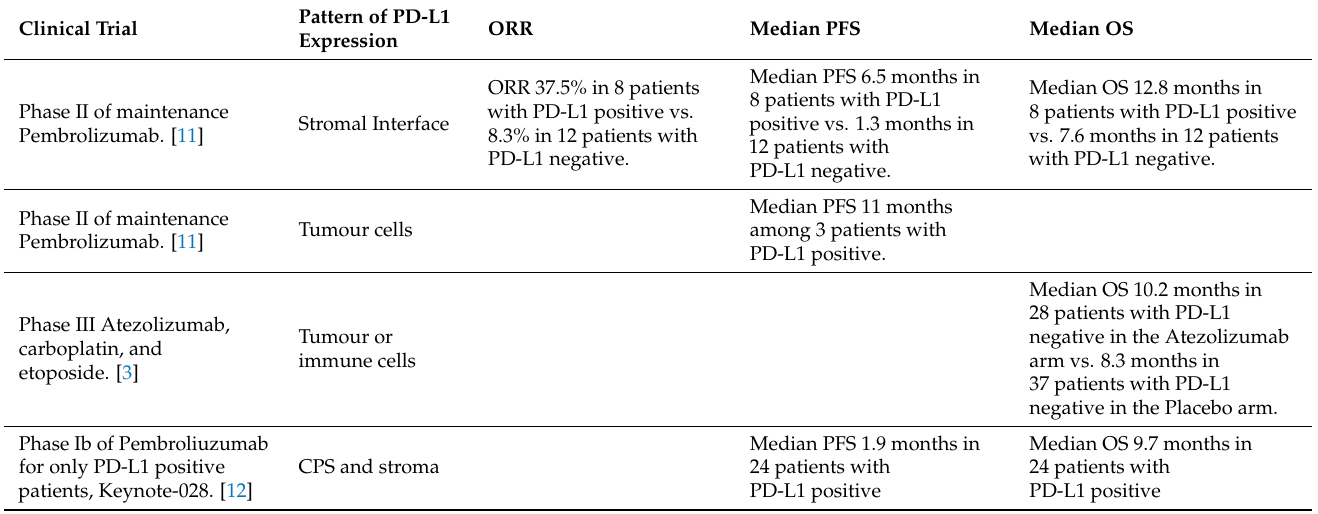
Table 1. Studies concerning PD-L1 expression in